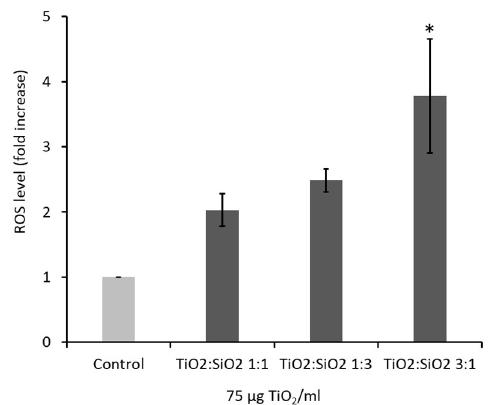
Figure 5. Oxidative stress was evaluated by detecting ROS in A549 after 180 min of exposure to TiO 2 :SiO 2 NPs (75 µ g TiO 2 / mL) by using the fluorescent probe DCFDA. The histograms represent the mean ± SE of at least three independent experiments. * Statistically significant with respect to control; One-way ANOVA + Bonferroni’s post hoc test; p < 0.05.